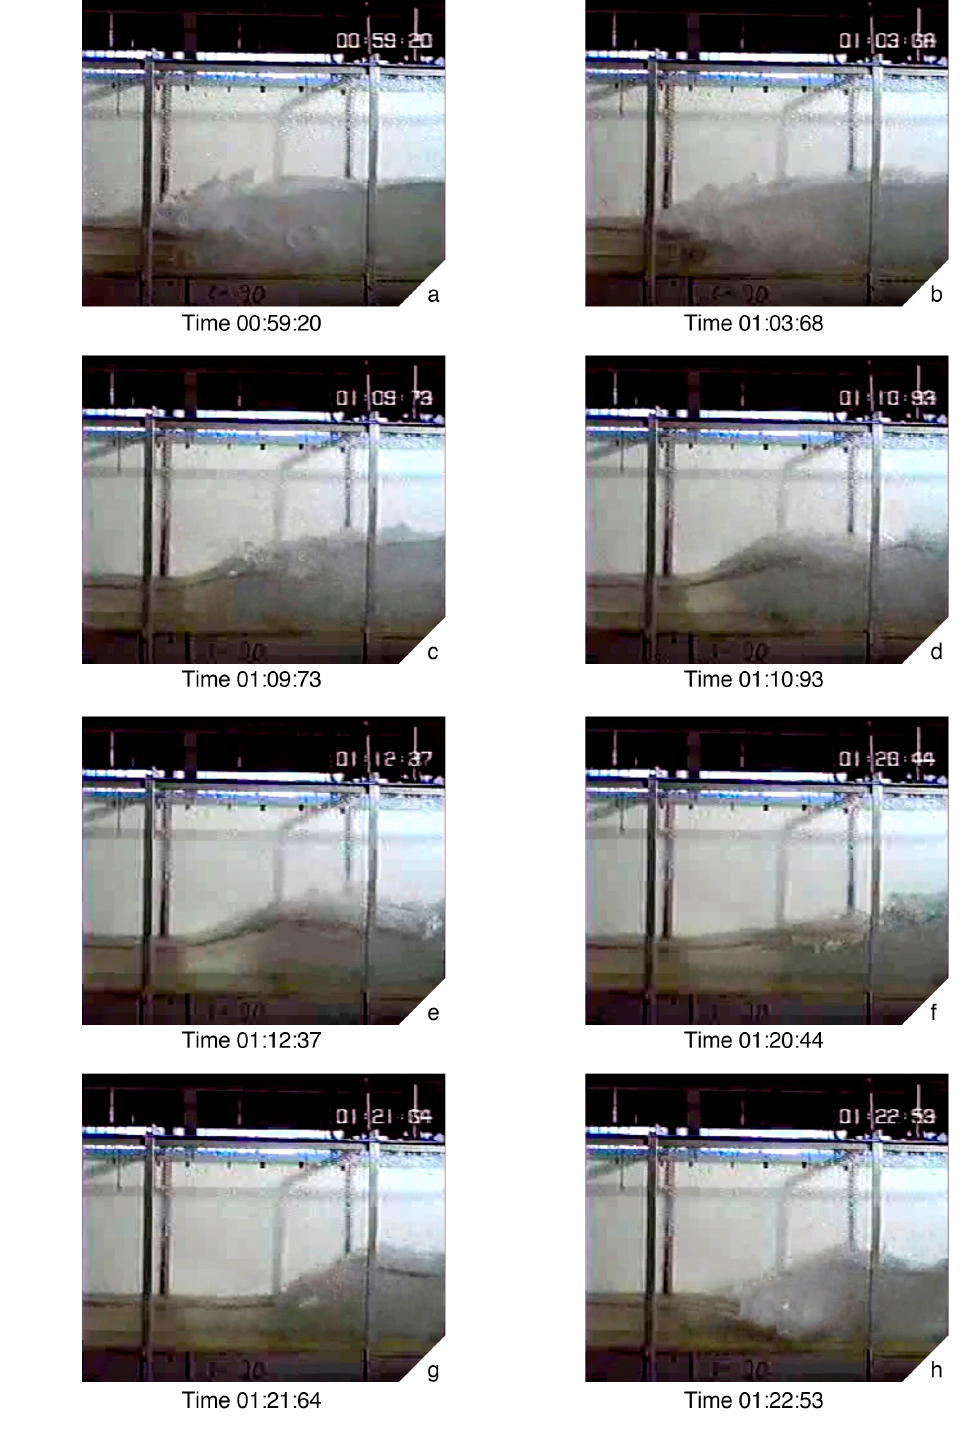
Figure 5. Oscillatory flow patterns between B-jumps and wave jumps (configuration B61 in Mossa et al. [50]); time is expressed in minutes, seconds, and hundredths of seconds from the start of filming (by Mossa et al. [50]): ( a , b , g , h ) B-jumps; ( c – f ) wave jumps. (See Video S2 in Supple- mentary